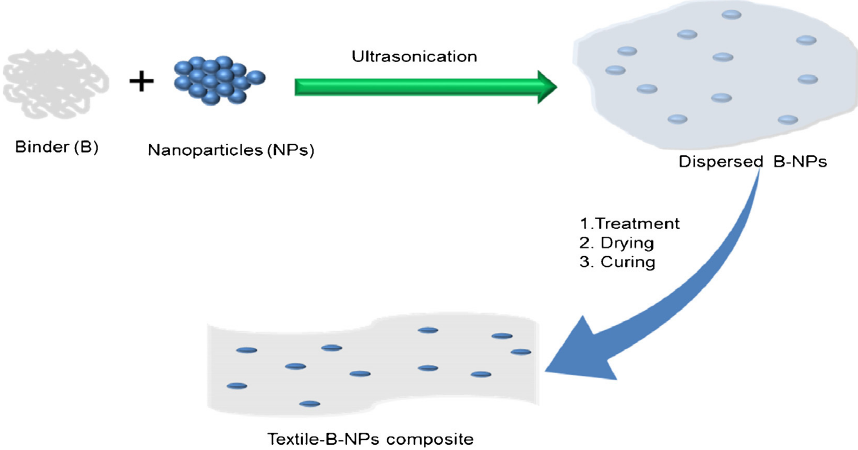
Figure 5. Schematic diagram showing the synthesis of coating dispersion and treatment on textile fabrics. Reproduced with permission [12]. Copyright 2017, Elsevier.